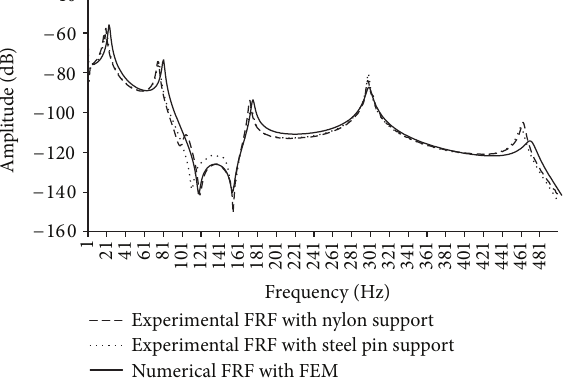
Figure 6: Experimental FRF (11,7)𝑦 (for both supports) and numeri- cal FRF (11,7)𝑦 .